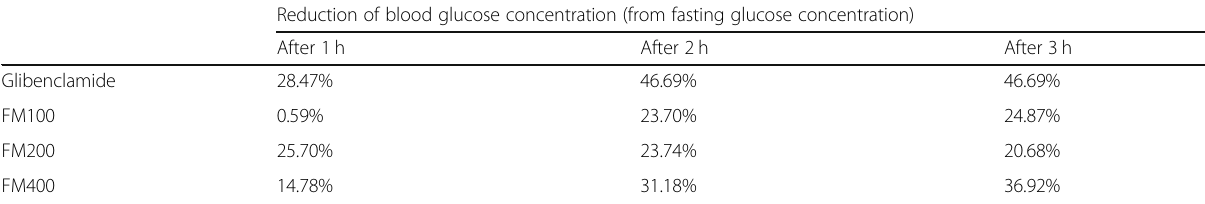
Table 1 Percentage reduction of blood glucose concentration by methanolic extract of leaf of Fimbristylis miliacea Reduction of blood glucose concentration (from fasting glucose